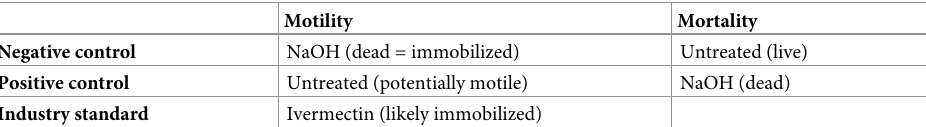
Table 1. Definition of specific controls used in this